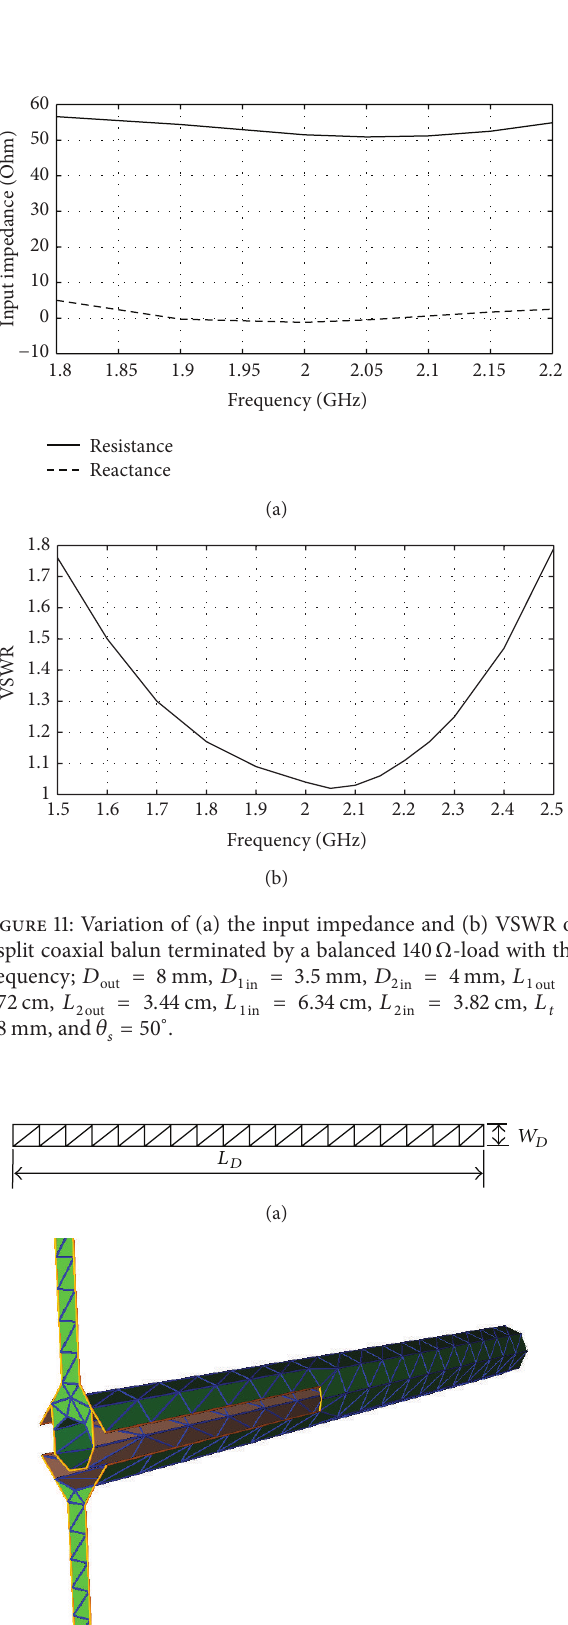
Figure 12: Geometric model of (a) strip dipole antenna with the dimensional parameters and (b) strip dipole antenna fed through a split coaxial balun (zoom-in view at the feeding